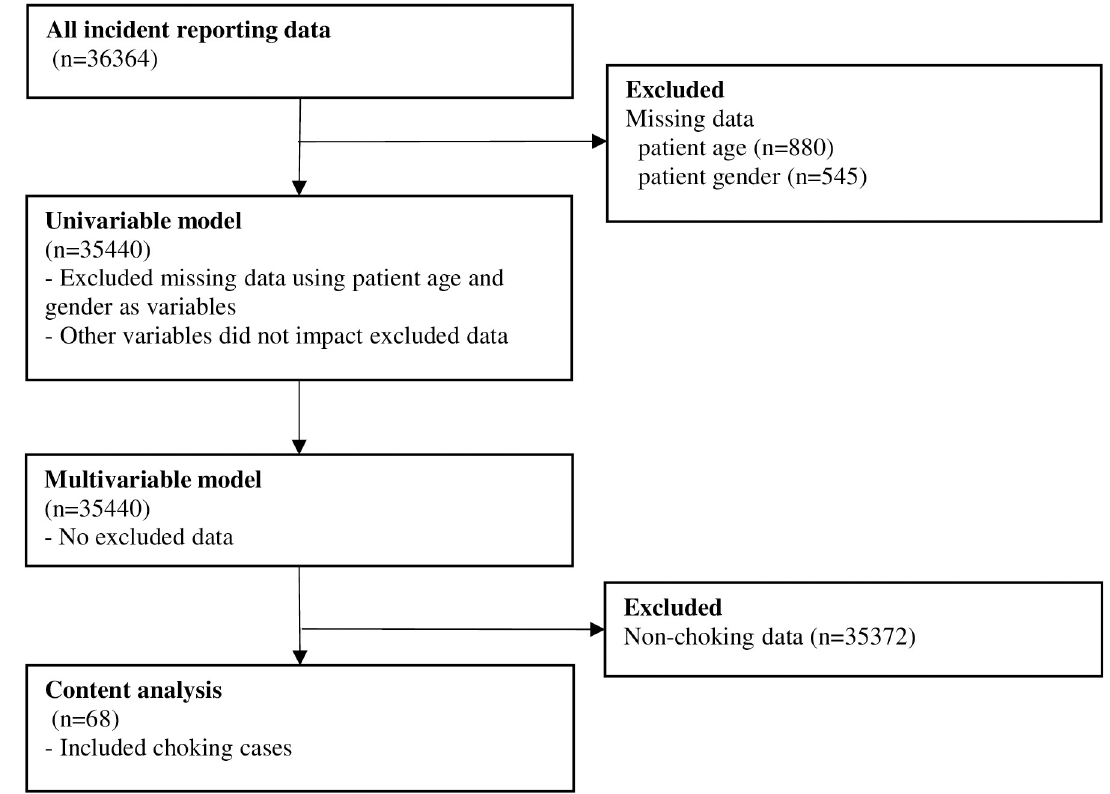
Fig 1. Flow diagram demonstrating the study